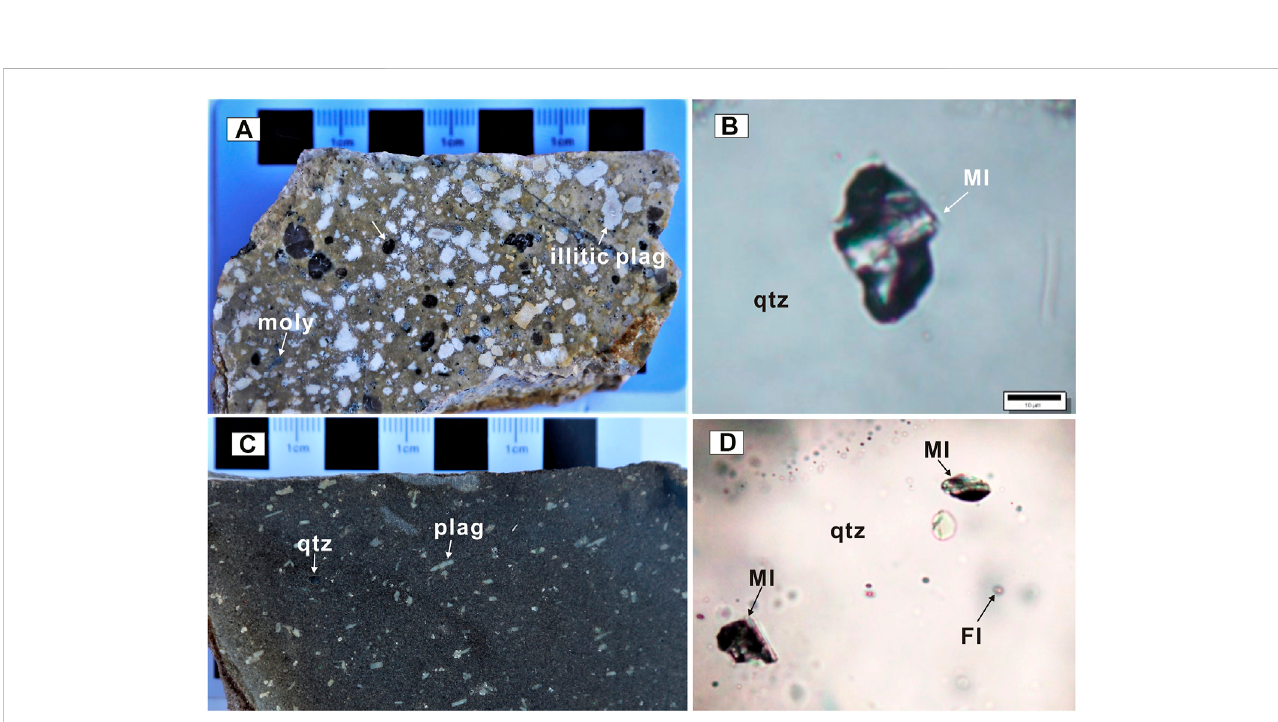
FIGURE 9 Representative hand specimen of quart monzonite porphyry and dacite porphyry and photomicrographs of melt inclusions within them. (A) quart monzonite porphyry comprising of plag (45%), qtz (10%), and matrix (45%). (B) totally isolated crystalline melt inclusion hosted in quartz of monzonite porphyry. (C) dacite porphyry consisting of plag + quartz (10%) and matrix (90%). (D) quartz-hosted melt inclusions in dacite porphyry. Abbreviations: qtz- quartz, plag – plagioclase, melt inclusion – MI, fl uid inclusion – FI.